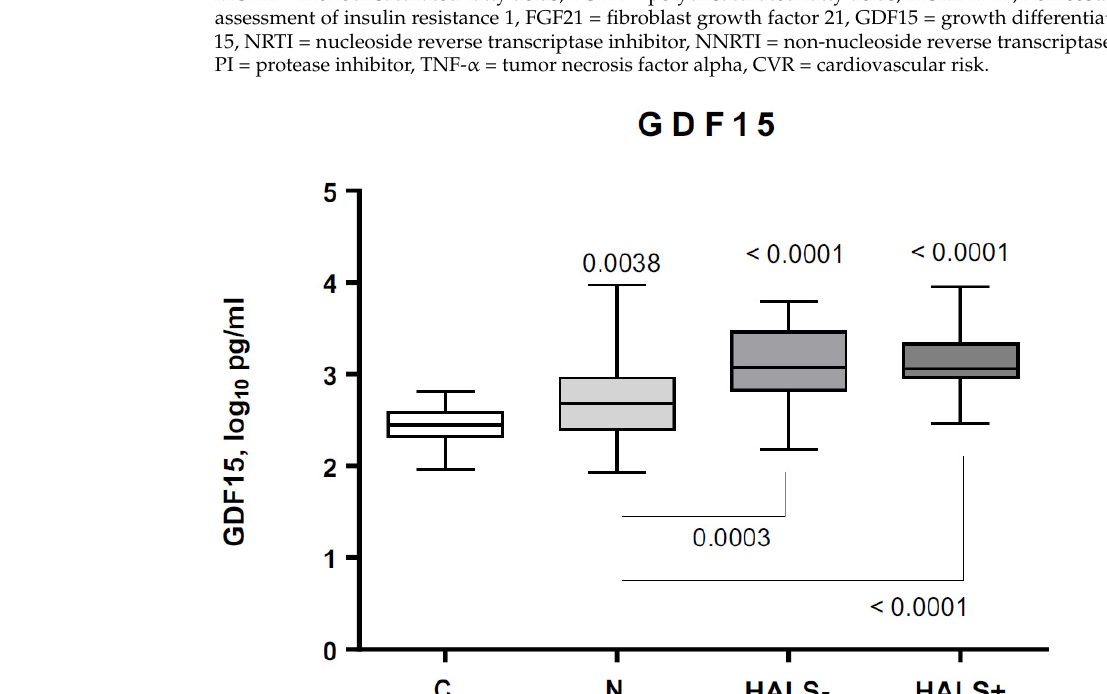
factor alpha, CVR = cardiovascular risk.